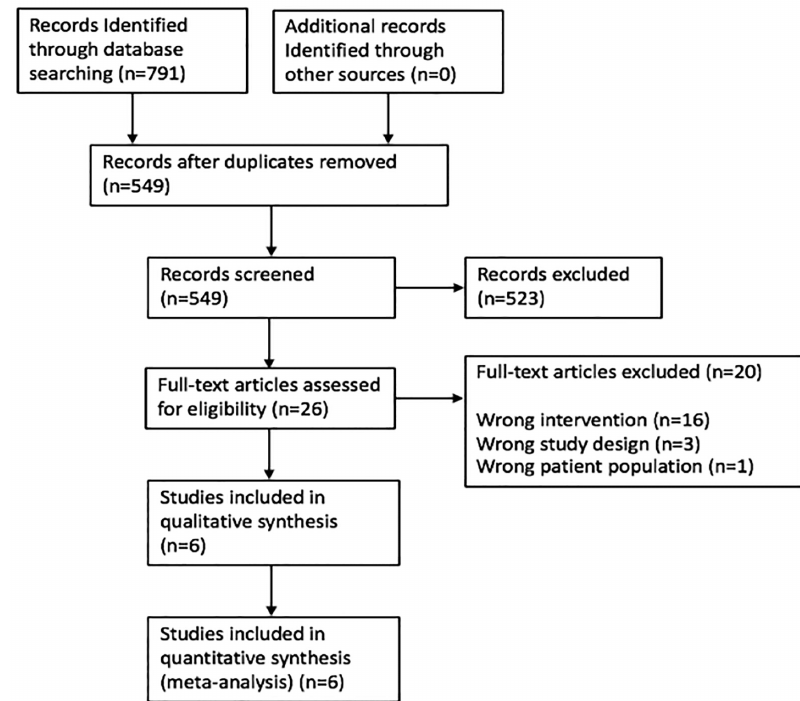
Figure 1. Preferred Reporting Items for Systematic Reviews and Meta-analyses (PRISMA) flow diagram. No additional articles were identified through bibliographic